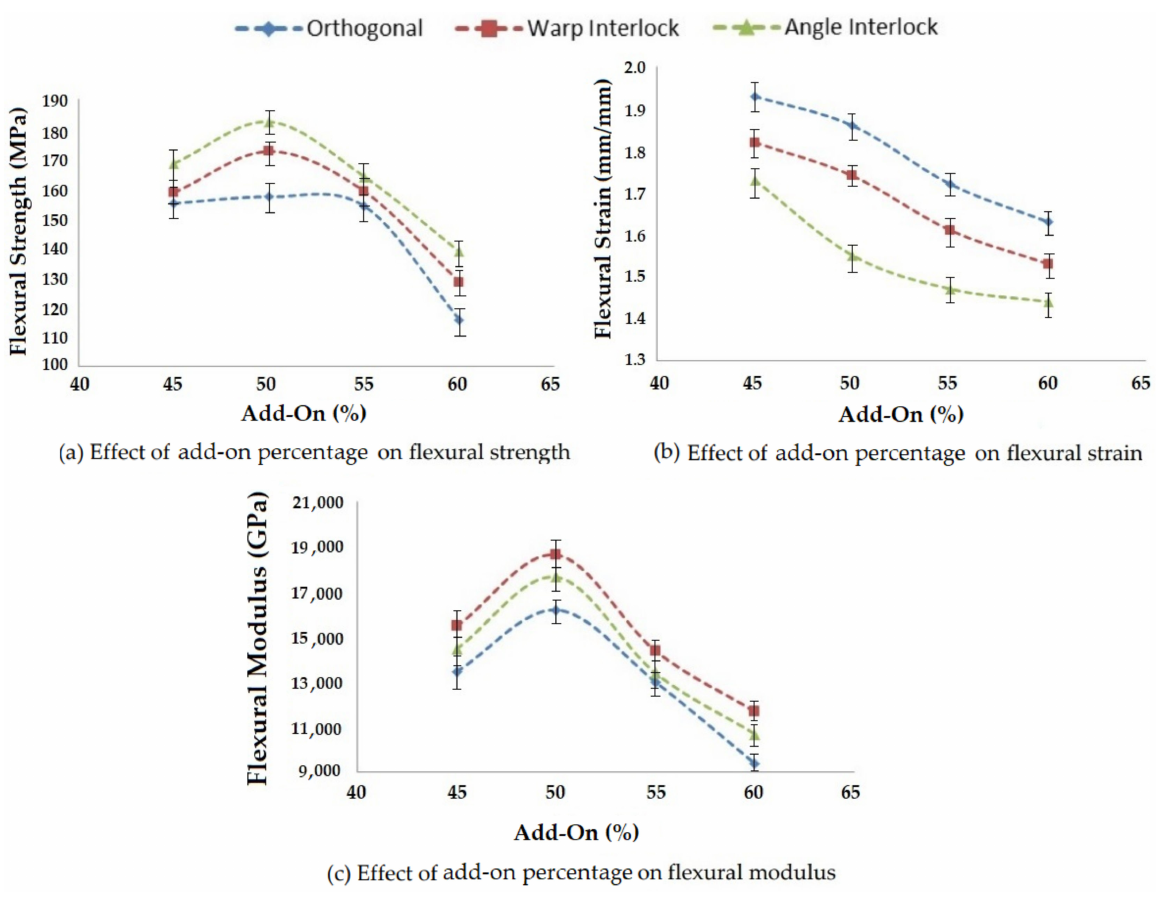
Figure 18. Effect of add-on percentage on the flexural properties of 3D woven